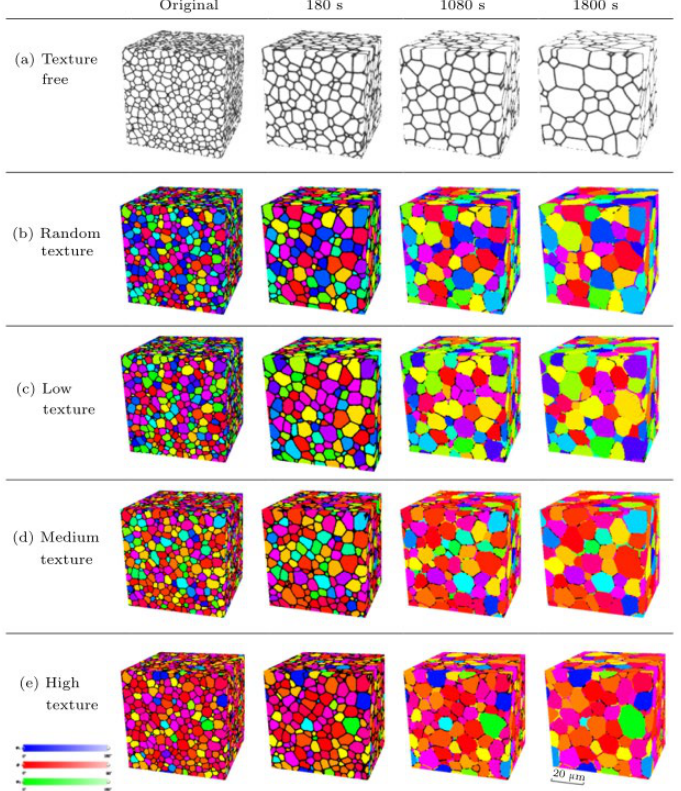
Figure 14. Microstructure evolution with time under different conditions: ( a ) texture free, ( b ) random texture, ( c ) low texture, ( d ) medium texture, and ( e ) high texture [117].